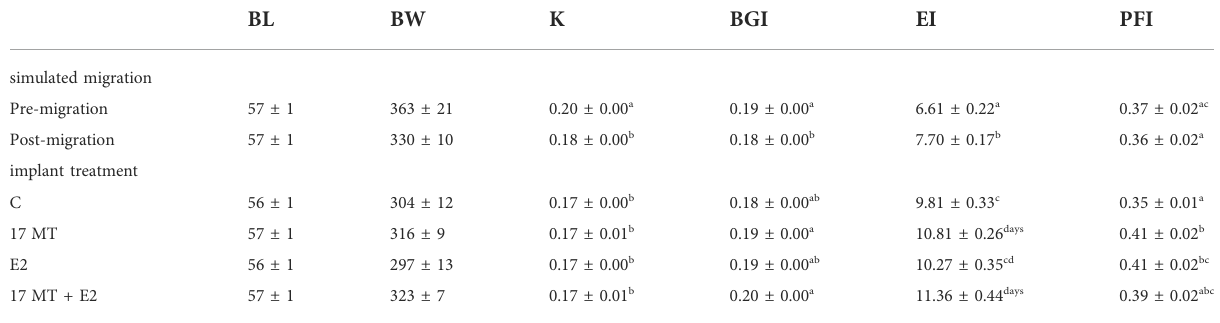
TABLE 2 Biometry (Mean ± SEM). Measurements on eels dissected before (pre) simulated migration ( N = 10) and after (post) simulated migration ( N = 10), and eels after implant treatment ( N = 10) for each treatment group with C = control with sham implant; 17 MT = 17 α methyltestosterone implant;E2=17 β -estradiolimplant,and17 MT+E2=theco-implantation.Abbreviations:BL=bodylength;BW=bodyweight;K=Fulton ’ scondition factor; BGI = body girth index; EI = eye index; PFI = pectoral fi n index. K, BGI, EI and PFI were tested for statistical differences between groups which are indicated by letters a-d.